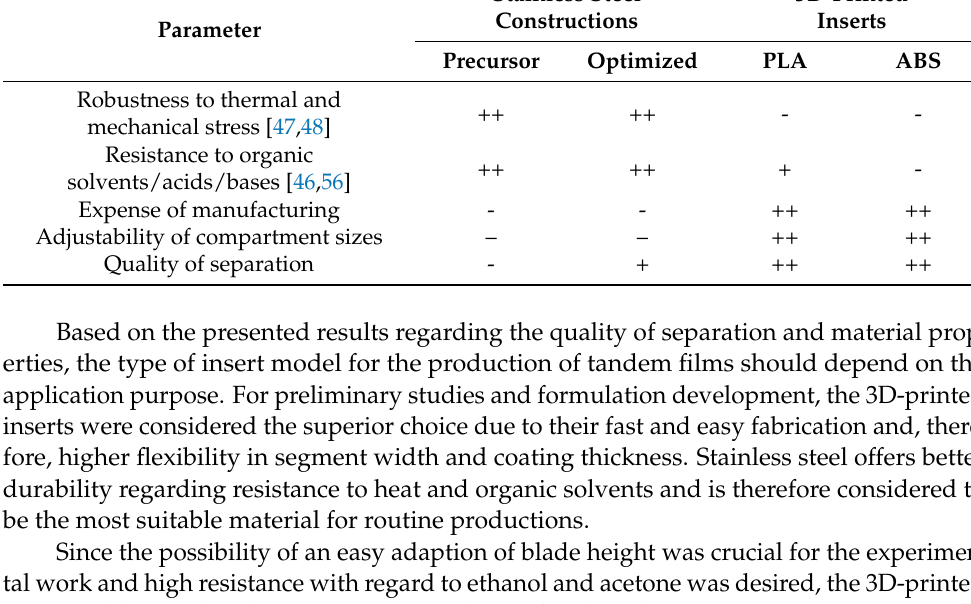
Table 6. Evaluation of the materials for coating blade inserts based on field experience and literature data (++: excellent, +: good, -: poor, –: absent). Stainless Steel Constructions Parameter Precursor Optimized PLA ABS Robustness to thermal and mechanical stress [47,48] Resistance to organic solvents/acids/bases [46,56] Expense of manufacturing